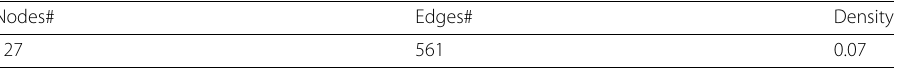
Table 14 The pathway one-mode projection network obtained from the private affiliation network Nodes# Edges# Density